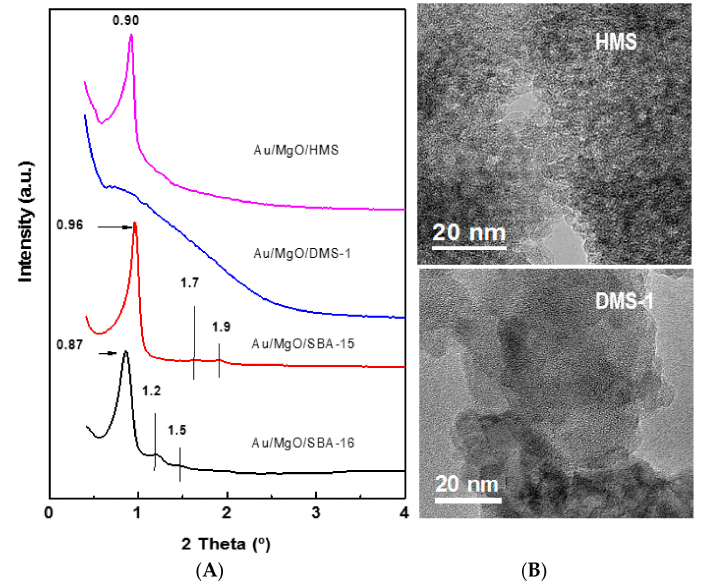
Figure 1. Low-angle XRD patterns of the as-prepared Au catalysts supported on different mesoporous silica substrates ( A ) and TEM images of the pure HMS and DMS-1 substrates showing wormhole and disordered porous support structures, respectively ( B